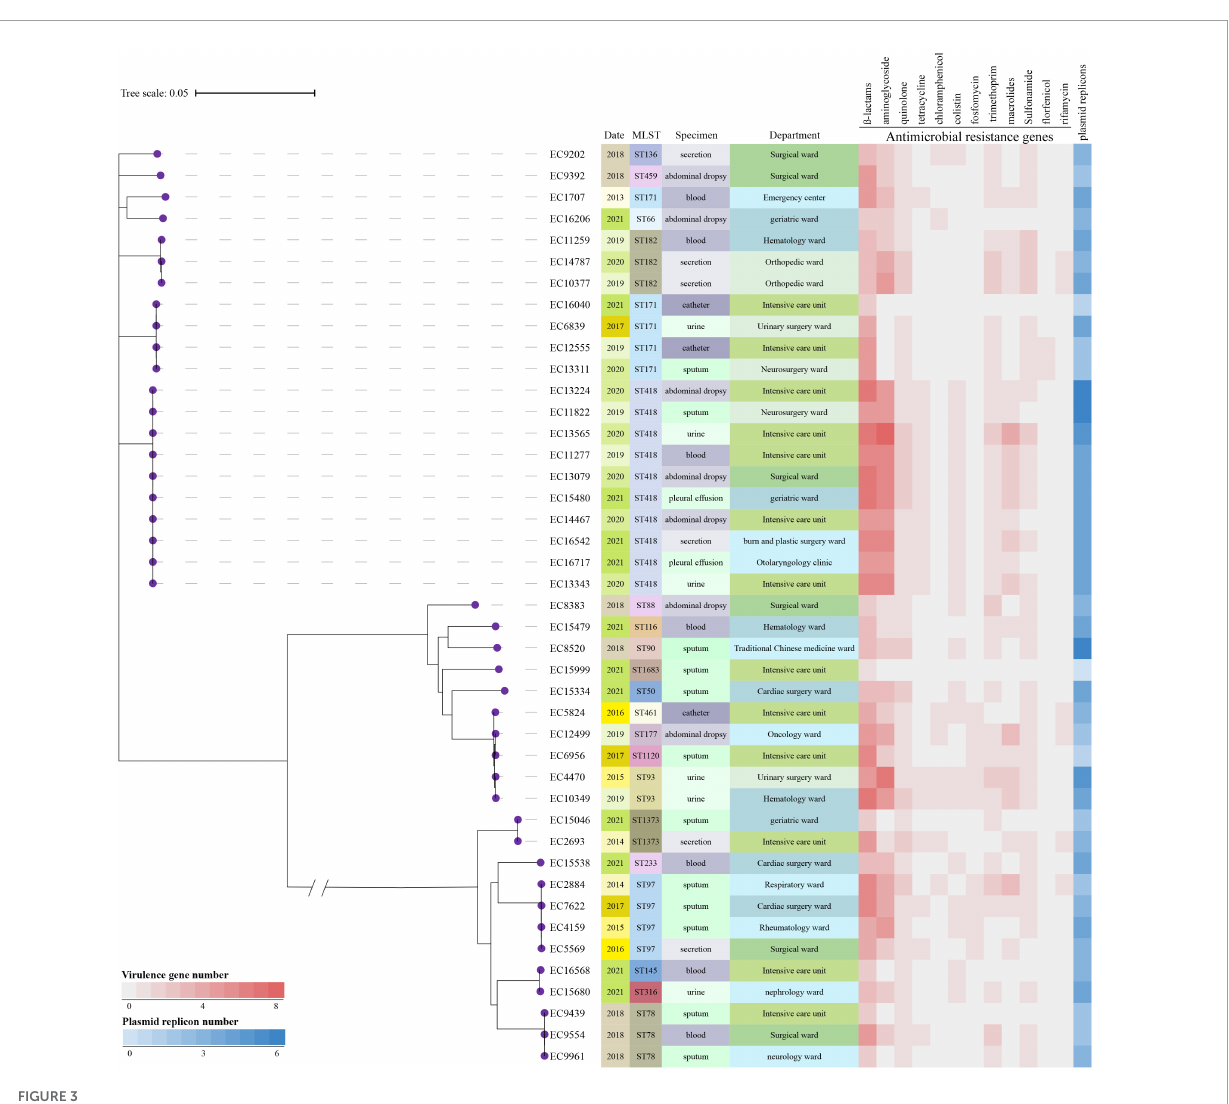
bla VIM-4 or bla NDM-1, but on different plasmids (Yuan et al., 2019; Soliman et al., 2020), and a clinic E. cloacae complex